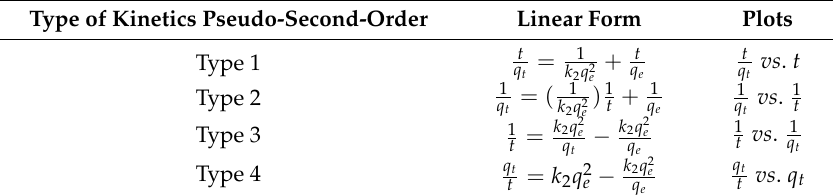
Table 5. Linear forms of the pseudo-second-order kinetics model.